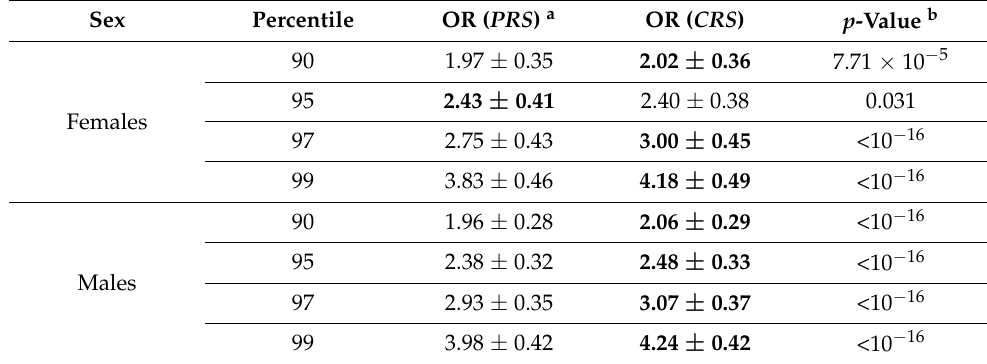
Figure 5. Odds ratio (OR) for T2D, based on PRS, CRS or age percentiles. ( A ) OR for all percentiles and all measures for females and males. Vertical lines correspond to the standard deviation of the average OR across 1000 random splits of the dataset. The horizontal line represents a neutral OR of 1. OR values for females and males in specific percentiles are also presented: ( B ) 90th, ( C ) 95th, ( D ) 97th and ( E ) 99th. Table 3. Average OR values for T2D for PRS and CRS by percentiles.